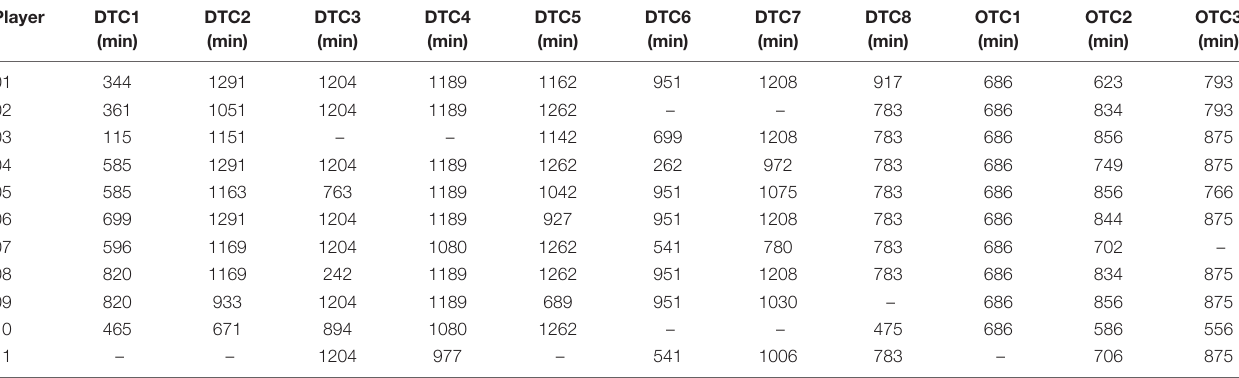
TABLE 2 | The individual exposure time to training during the training camps.